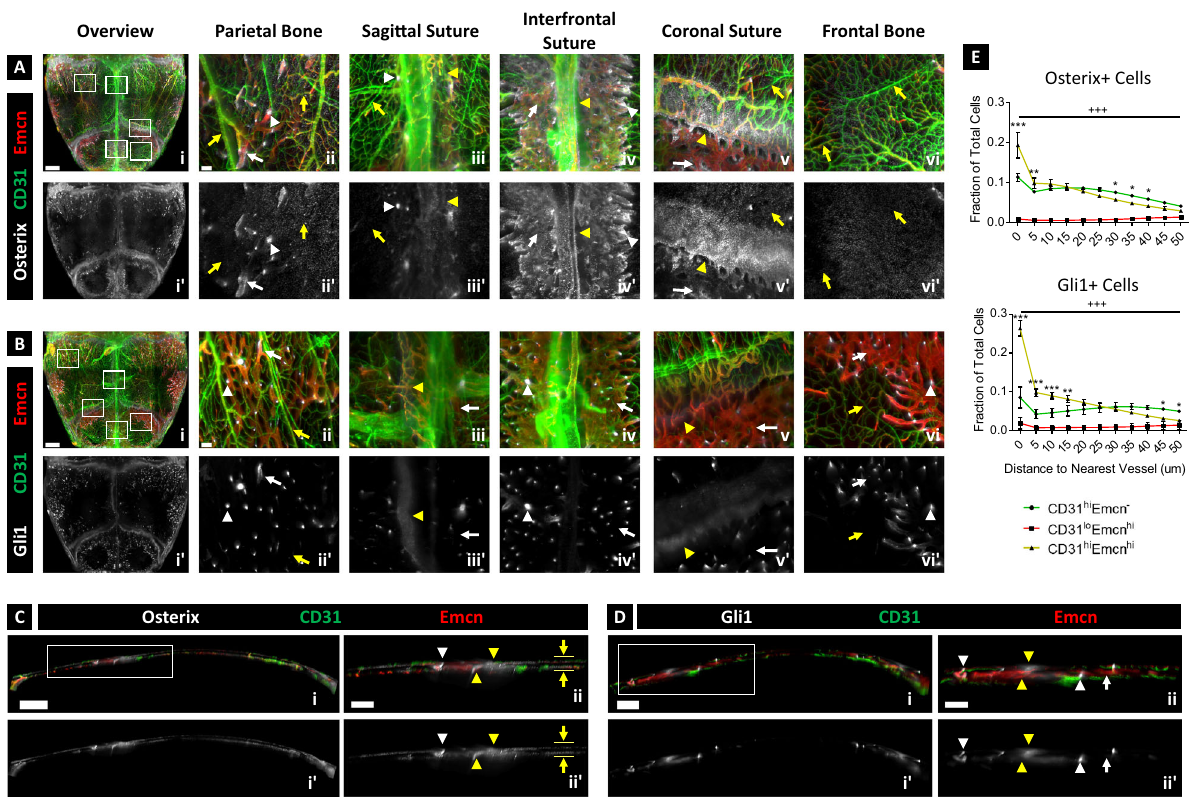
Fig. 2 3D map of the microvascular environment in 4-weeks-old murine calvaria. A , B MIP displaying calvarial vessels ( A i, B i) and Osterix + ( A i, A i ’ ) or Gli1 + skeletal progenitors ( B i, B i ’ ) in the parietal and posterior frontal bones of the calvarium. Zoomed-in images demonstrate the distribution of vessel phenotypes ( A ii – vi, B ii – vi) and skeletal progenitors ( A ii – vi, A ii ’– vi ’ , B ii – vi, B ii ’– vi ’ ) in different regions. C , D 50- μ m-thick sagittal sections showing the locations of vessels C i – ii, D i – ii) and skeletal progenitors ( C i – ii, C i ’– ii ’ , D i – ii, D i ’– ii ’ ) along the thickness of the calvarium. CD31 hi Emcn − and CD31 hi Emcn hi vessels are prevalent in the periosteum and dura mater (yellow arrows), while CD31 hi Emcn hi and CD31 lo Emcn hi vessels make up the majority of vessels in the bone marrow cavities (white arrows). Osterix + progenitors ( A , C ) are distributed throughout the periosteum and dura mater (yellow arrows), transcortical canals (white arrowheads), and osteogenic fronts nearby the sutures (yellow arrowheads), while Gli1 + progenitors ( B , D ) are mainly restricted to the transcortical canals and sutures. Results were replicated in 3 calvaria for each staining combination (CD31/Emcn/Osterix, CD31/Emcn/Gli1). E Plots showing the nearest distance of Osterix + (top) and Gli1 + (bottom) progenitors to each vessel phenotype ( n = 3). Both cell types exhibit a preferential spatial relationship to CD31 hi Emcn hi vessels compared to the other phenotypes. CD31 lo Emcn lo vessels were not quanti fi ed due to their low fl uorescence signal-to-noise ratio. Data are mean±SD. Statistics were performed using a two-way ANOVA and Bonferroni post-hoc test. *** p <0.001, ** p <0.01, * p <0.05 between CD31 hi Emcn hi and CD31 hi Emcn − vessels; +++ p <0.001 between CD31 lo Emcn hi and CD31 hi Emcn − vessels; Scale bars: 1000 μ m ( A i, B i), 100 μ m ( A ii – vi, B ii – vi), 700 μ m ( C i), 300 μ m ( C